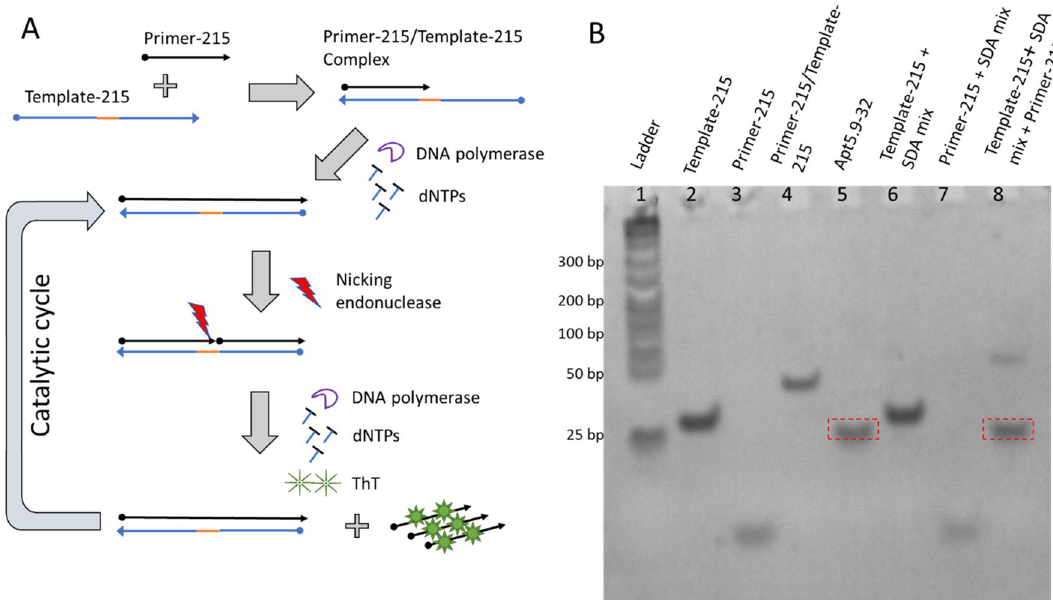
Figure 4. Strand displacement amplification (SDA) with ThT aptamer (Apt5.9-32) Reporter. ( A ) Schematic of strand displacement amplification with the ThT aptamer (Apt5.9-32) reporter system. ( B ) SDA product analysis by 12% PAGE. The red boxes indicate Apt5.9-32